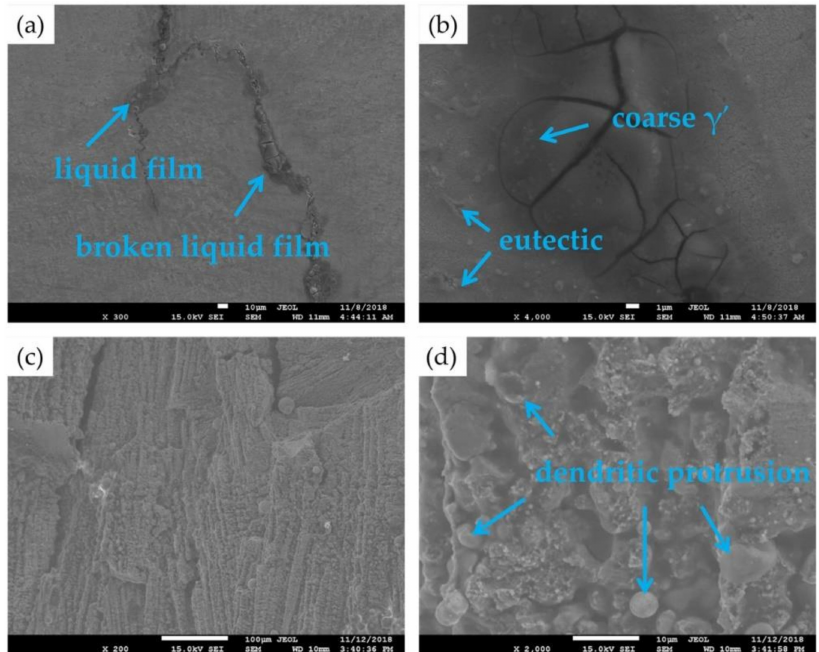
Figure 10. Morphology of ( a , b ) a liquation crack and ( c , d ) its section.